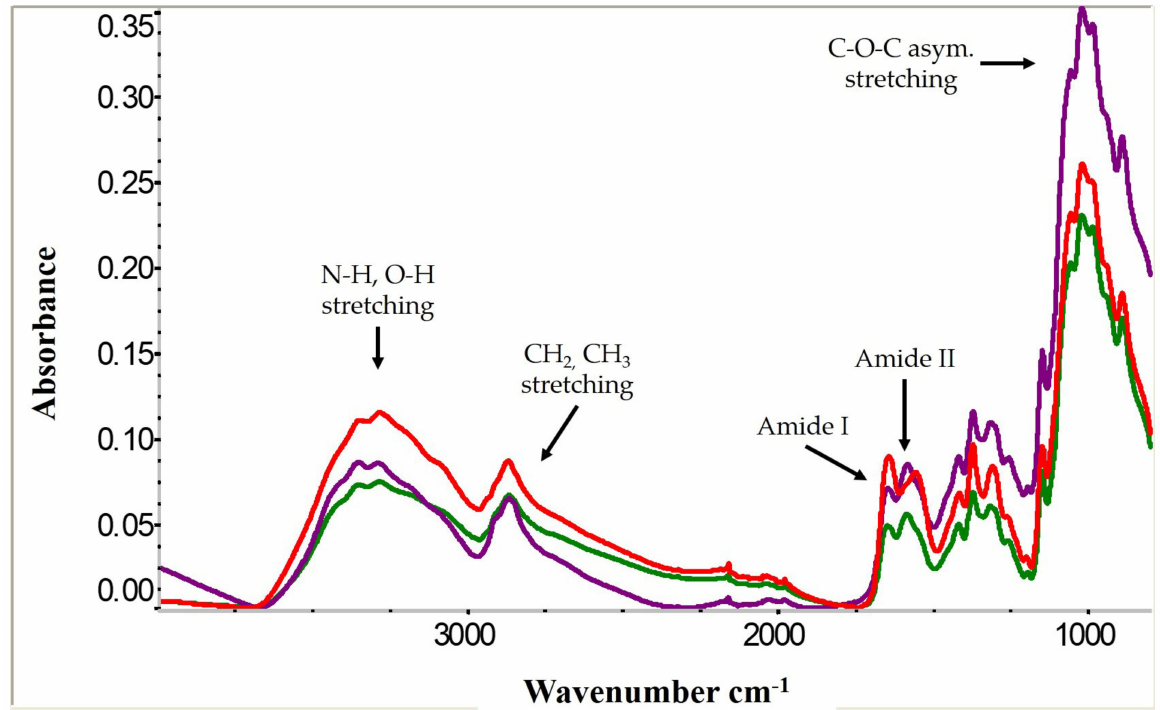
Figure 2. FTIR Characterization of A. domesticus ( green ) and G. sigillatus ( purple ) chitosan samples after 10 h of deacetylation, compared to commercial shrimp chitosan ( red